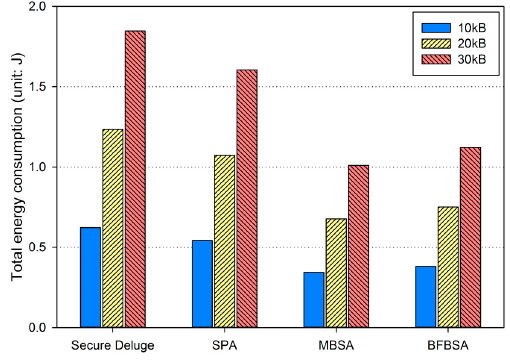
Figure 17. Total energy consumption.